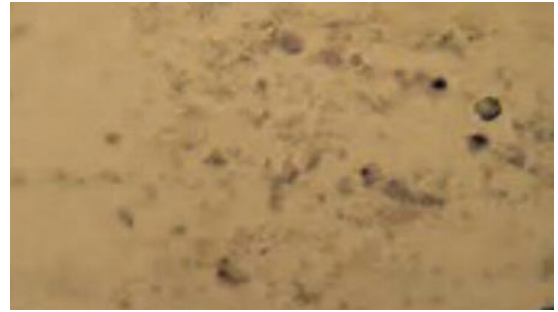
Blastocystis spp. cyst stained by Trichrome stain (large central vacuole stained gray-green color and the peripheral nuclei stained red-purple color)